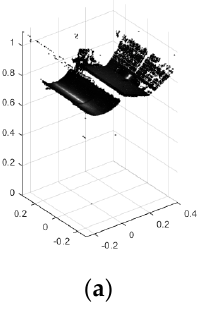
( c ) Figure 7. Experimental Data at 5H57M: ( a ) 3D Point Cloud; ( b ) Image of Camera; ( c ) Image of IP Camera. In the industrial 3D scanner, the most vulnerable component to radiation is the laser pattern projector, and the radiation resistances of the remaining components are un- known. Considering that the quality of the images captured by the camera in the indus- trial 3D scanner is maintained for the last 5 min, the radiation resistance of the camera is larger than the radiation resistance of the laser pattern projector. However, the exact radi- ation resistance of the camera cannot be determined. Because the monitoring program stops working due to no response of the industrial 3D scanner, the exact surviving time of the other embedded computer is unknown. At the ping test after the irradiation exper- iment, the embedded computer in the industrial 3D scanner responds normally and the other embedded computer without a shield does not respond. Figure 8a is an image of the IP camera at the start of irradiation, and Figure 8b is an image of the IP camera at the end of irradiation. The noise observed in Figure 8a is the photon shot noise generated during irradiation, and it disappears at the end of irradiation as shown in Figure 8b. In all optical components, no significant deterioration is observed after irradiation with the naked eye. The reason why the silver-coated mirror in Figure 8b turned slightly yellow is because the substrate of the silver-coated mirror is discolored. In the case of a first surface mirror, the discoloration of the substrate does not affect the re- flectivity of the mirror.